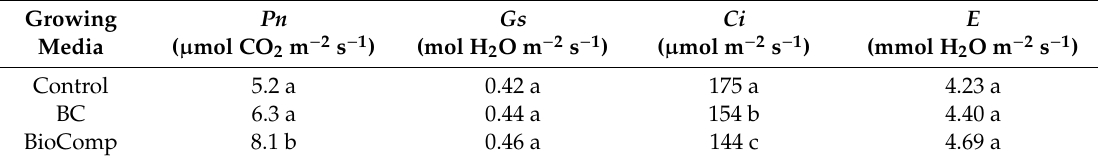
Table 6. Physiological characteristics of Syngonium podophyllum cultivated in di ff erent growing media. Growing